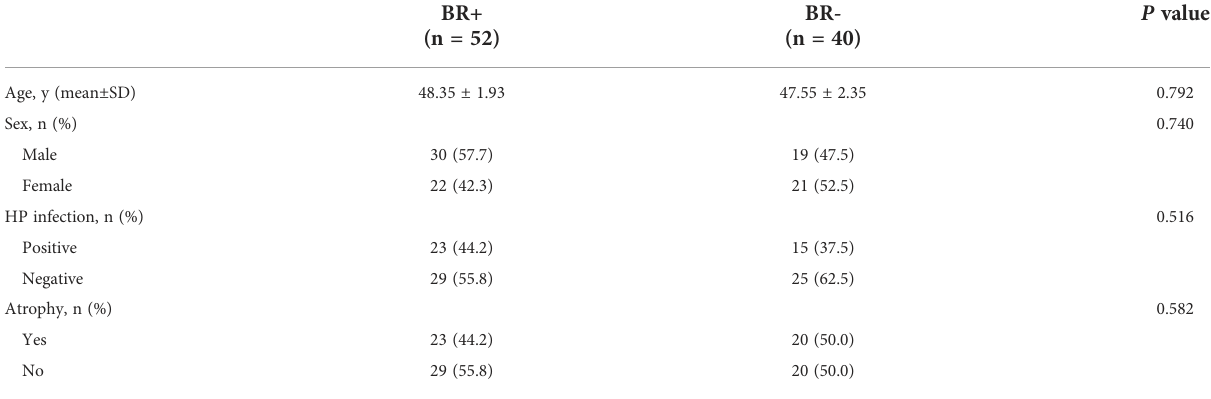
TABLE 1 Characteristics of the study